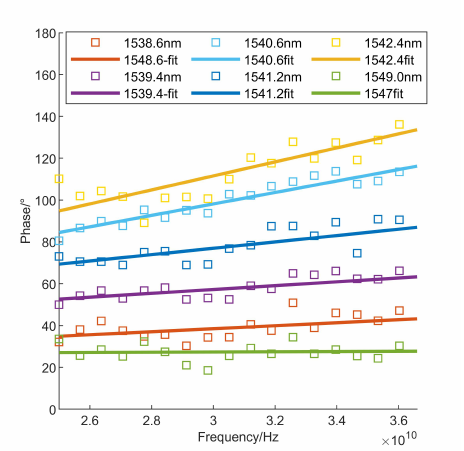
Figure 7. Phase response of different